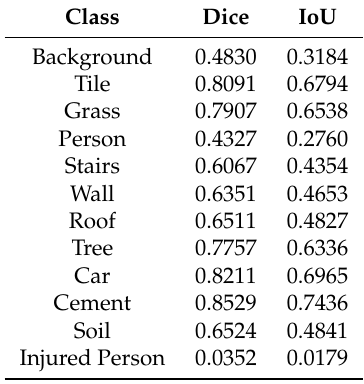
Table 4. Results on the test dataset for each